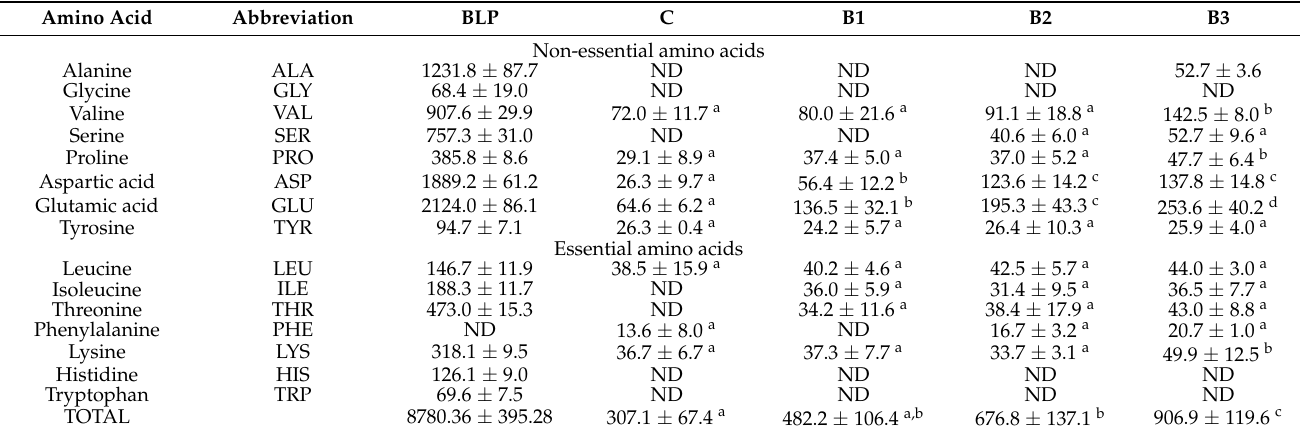
Table 2. Amino acid profile in BLP and BLP fortified GFM extracted using method 2. Data expressed in nmol/g DM. (ND—not detected). Different letters in superscript in the same line indicate a significant difference ( p < 0.05) (Fisher’s LSD. ANOVA). C—control, B1—2.5% starch replacement